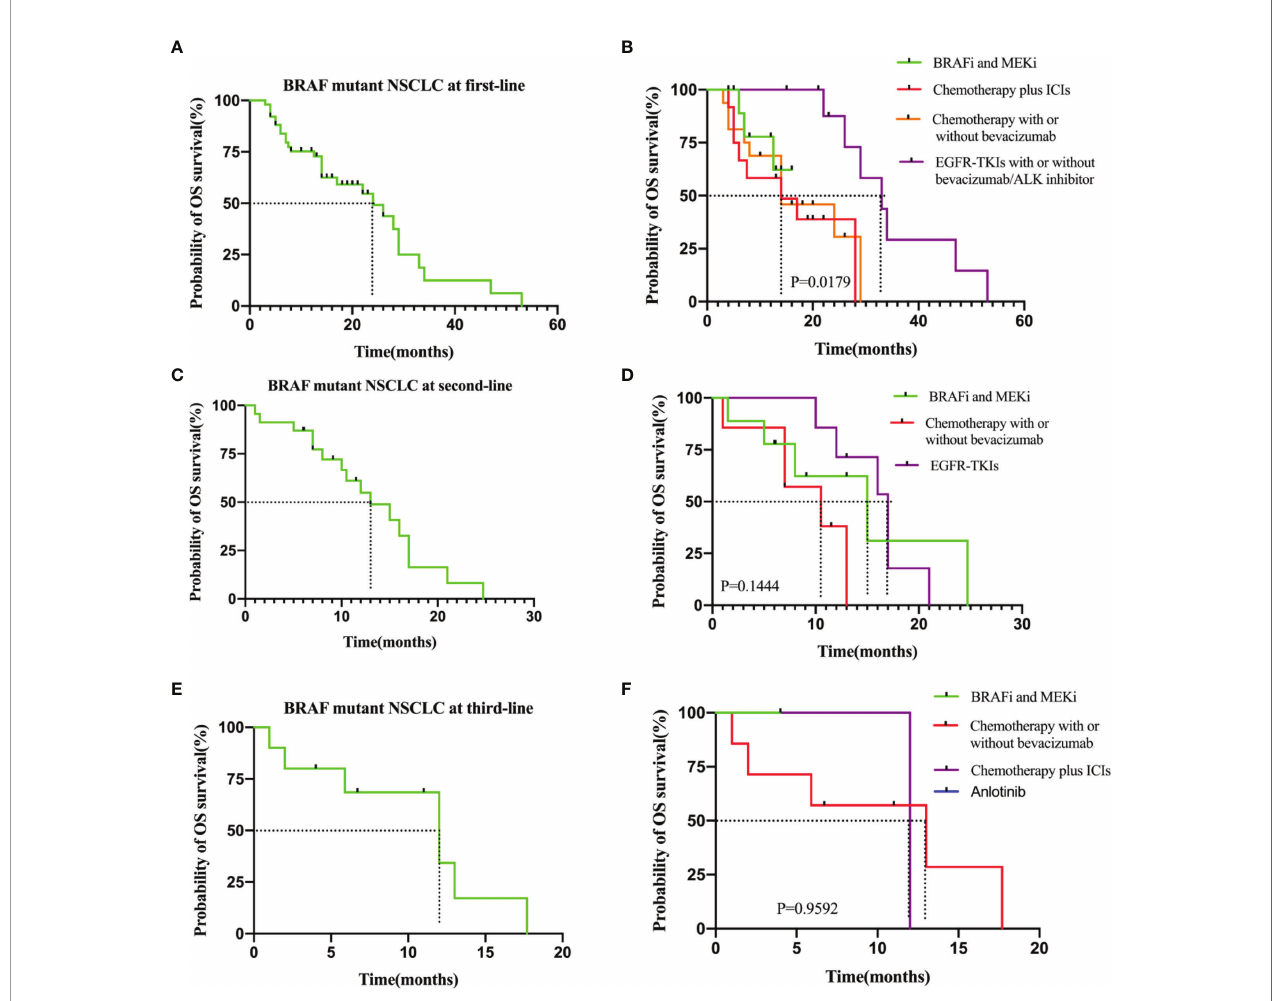
FIGURE 3 | (A) OS in the all patients at fi rst-line. (B) OS in the subgroup of patients who received BRAF and MEK inhitor (n = 12), chemotherapy plus ICIs (n = 12), chemotherapy with or without bevacizumab (n=16) and EGFR-TKIs with or without bevacizumab/ALK inhibitor (n = 11). (C) OS in the all patients at second- line. (D) OS in the subgroup of patients who received BRAF and MEK inhitor (n = 9), chemotherapy with or without bevacizumab (n=7) and EGFR-TKIs (n=7). (E) OS in the all patients at third-line. (F) OS in the subgroup of patients who received chemotherapy with or without bevacizumab (n = 7), BRAF and MEK inhitor (n = 1), chemotherapy plus ICIs (n=2) and anlotinib